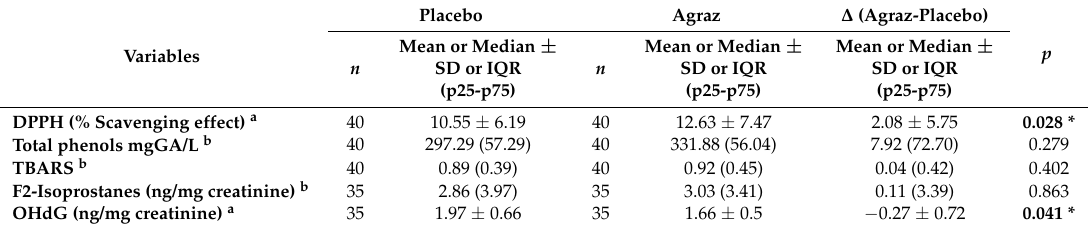
Table 3. Changes in antioxidant capacity and oxidation markers in women with metabolic syndrome after agraz consumption compared to placebo.